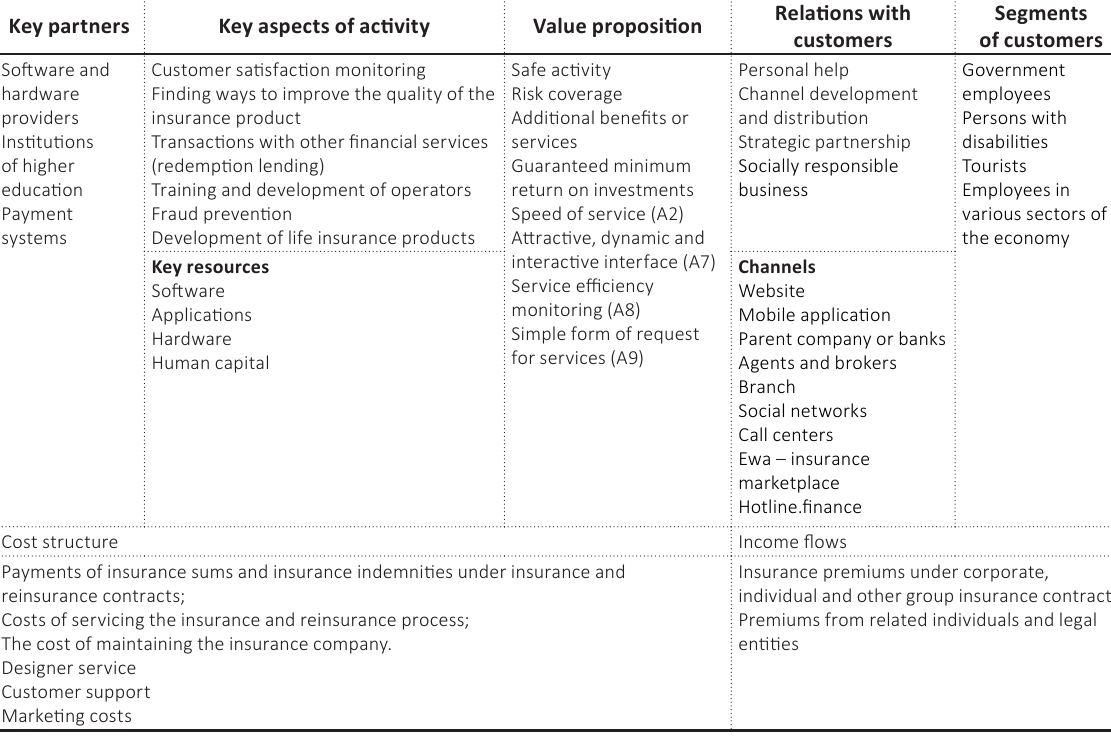
Table 9. Business model of insurance companies from the LIFE segment